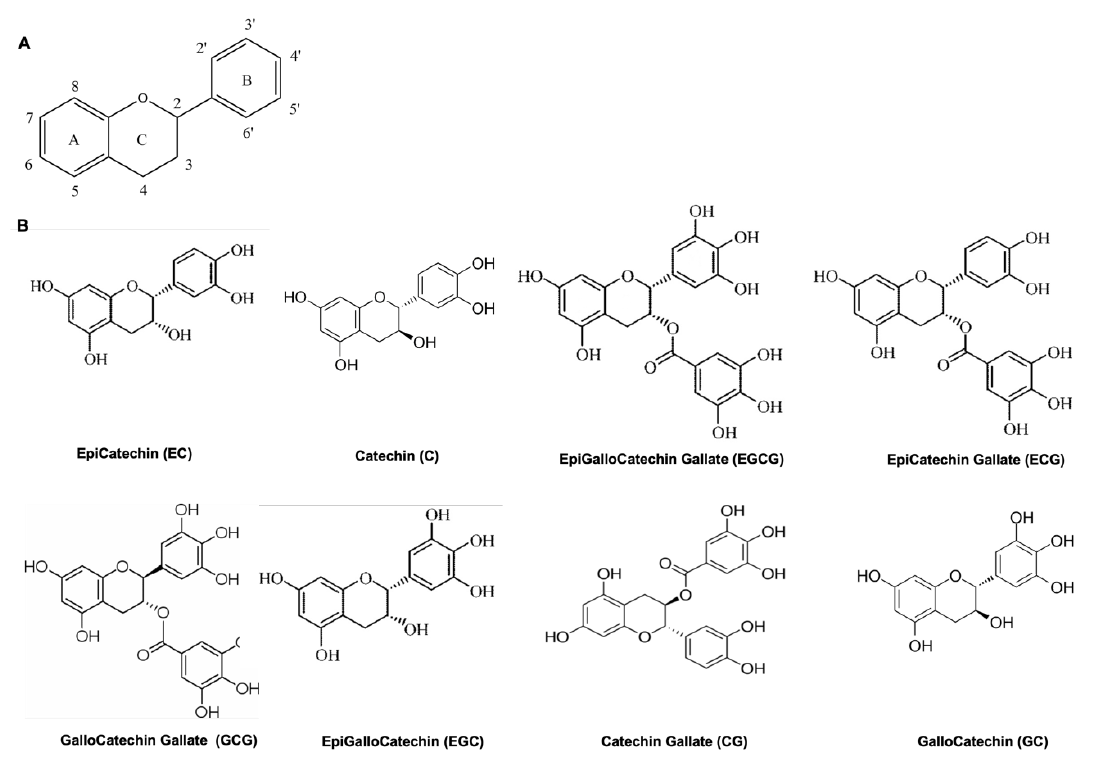
Figure 1. ( A ) Structure of the flavan nucleus, the basic structure of flavonoids. ( B ) Structure of eight catechins. Catechins have many chemical structural features, such as hydroxyl groups ( – OH), that combine easily with other materials.